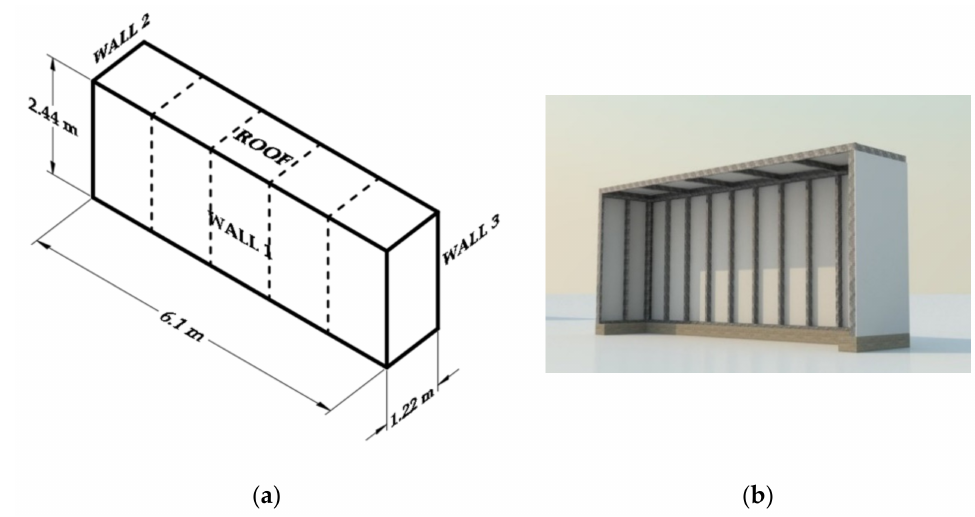
Figure 1. 3D Views in full-scale of the experimental specimen: ( a ) Geometry properties; ( b ) In- side